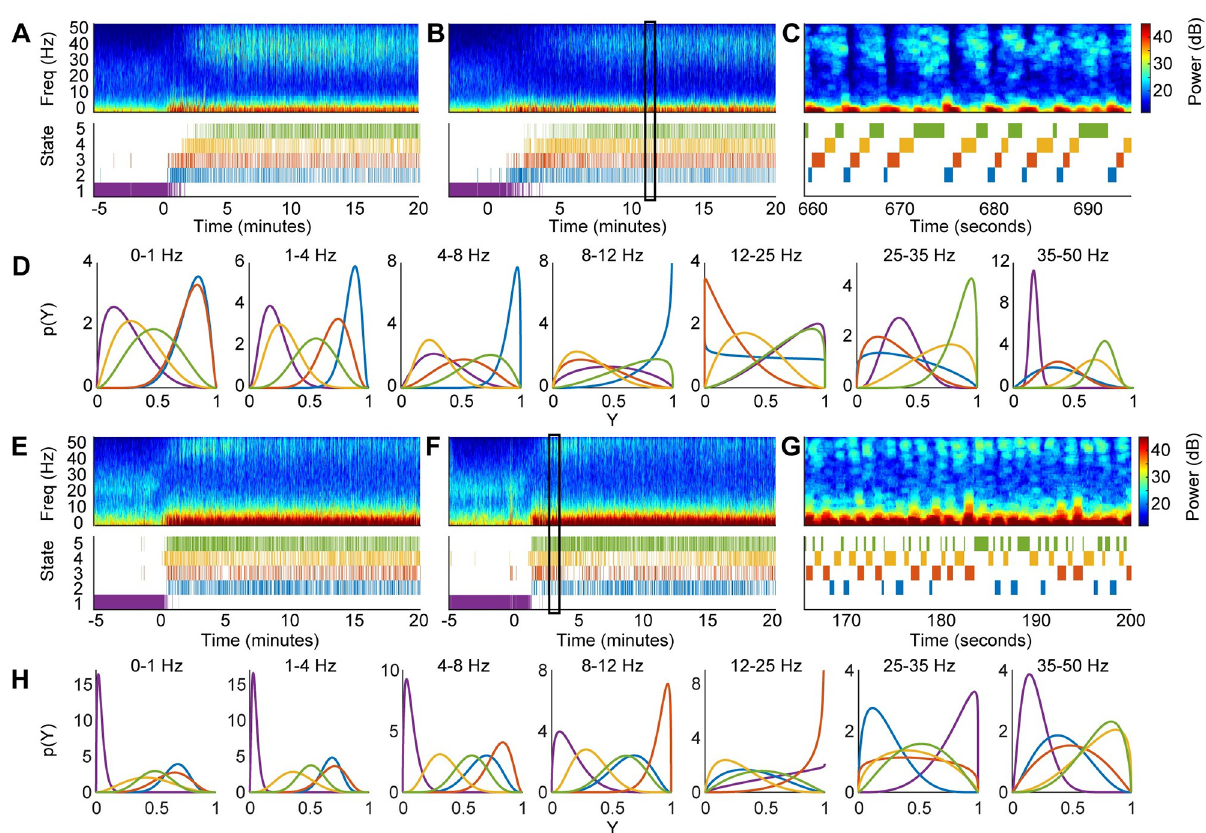
Fig 4. The 5-state beta-HMM can be fit across multiple sessions to create NHP-specific models. (A,B) Multitaper spectrograms of LFP and corresponding estimated latent state trajectories from 2 of 4 sessions in NHP MJ. (C) Enlarged view of a typical 35s epoch indicated by the rectangular portion in panel B. (D) Frequency band-specific beta pdfs for each of the 5 states estimated from the 4 sessions in NHP MJ (Y—scaled power). Each color corresponds to a state, as denoted in the state trajectories in panels A-C. (E,F) Multitaper spectrograms of LFP and corresponding estimated latent state trajectories from 2 of 5 sessions in NHP LM. (G) Enlarged view of a typical 35s epoch indicated by the rectangular portion in panel F. (H) Frequency band-specific beta pdfs for each of the 5 states estimated from the 5 sessions in NHP LM (Y—scaled power). Each color corresponds to a state, as denoted in the state trajectories in panels